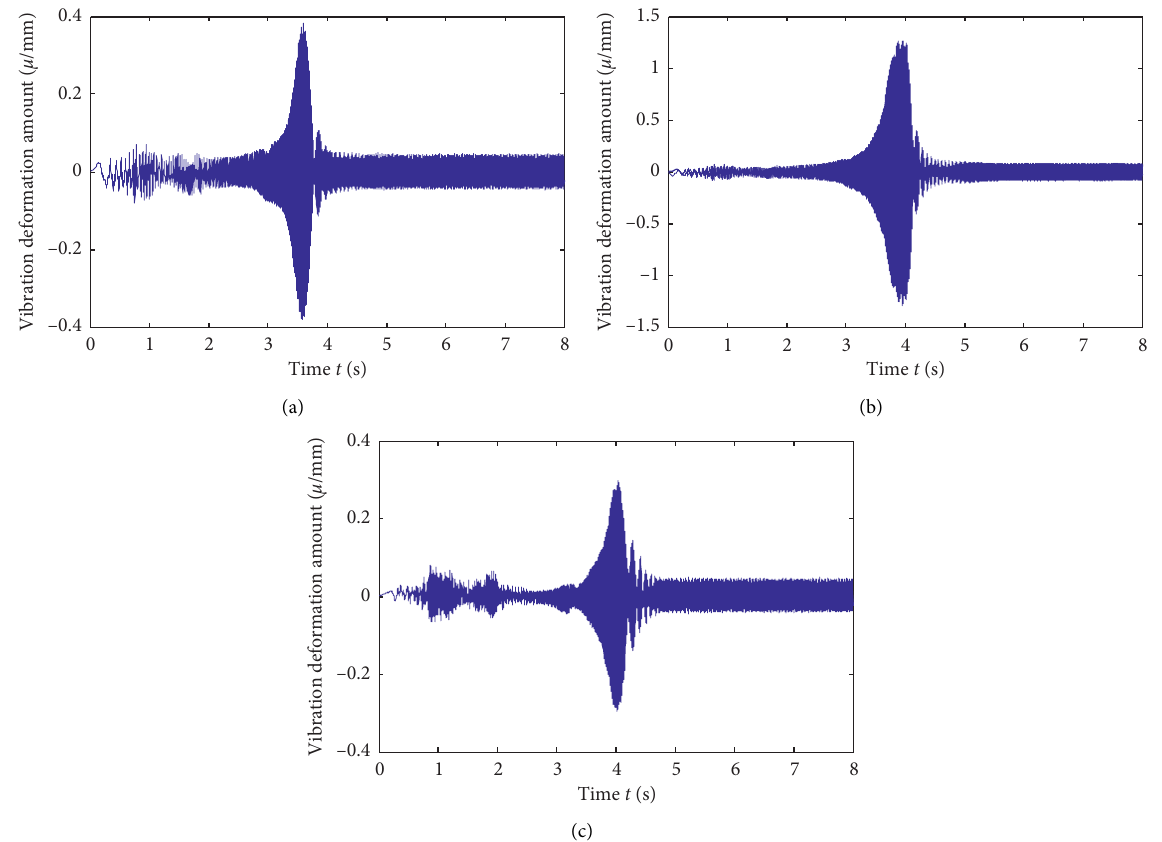
Figure 11: Effect of the position of support I on the vibration deformation of the shafting across the first-order critical speed. (a) Supports’ positions − 40mm, 0mm, 0mm. (b) Supports’ positions 0mm, 0mm, 0 mm. (c) Supports’ positions 40mm, 0 mm, 0 mm.